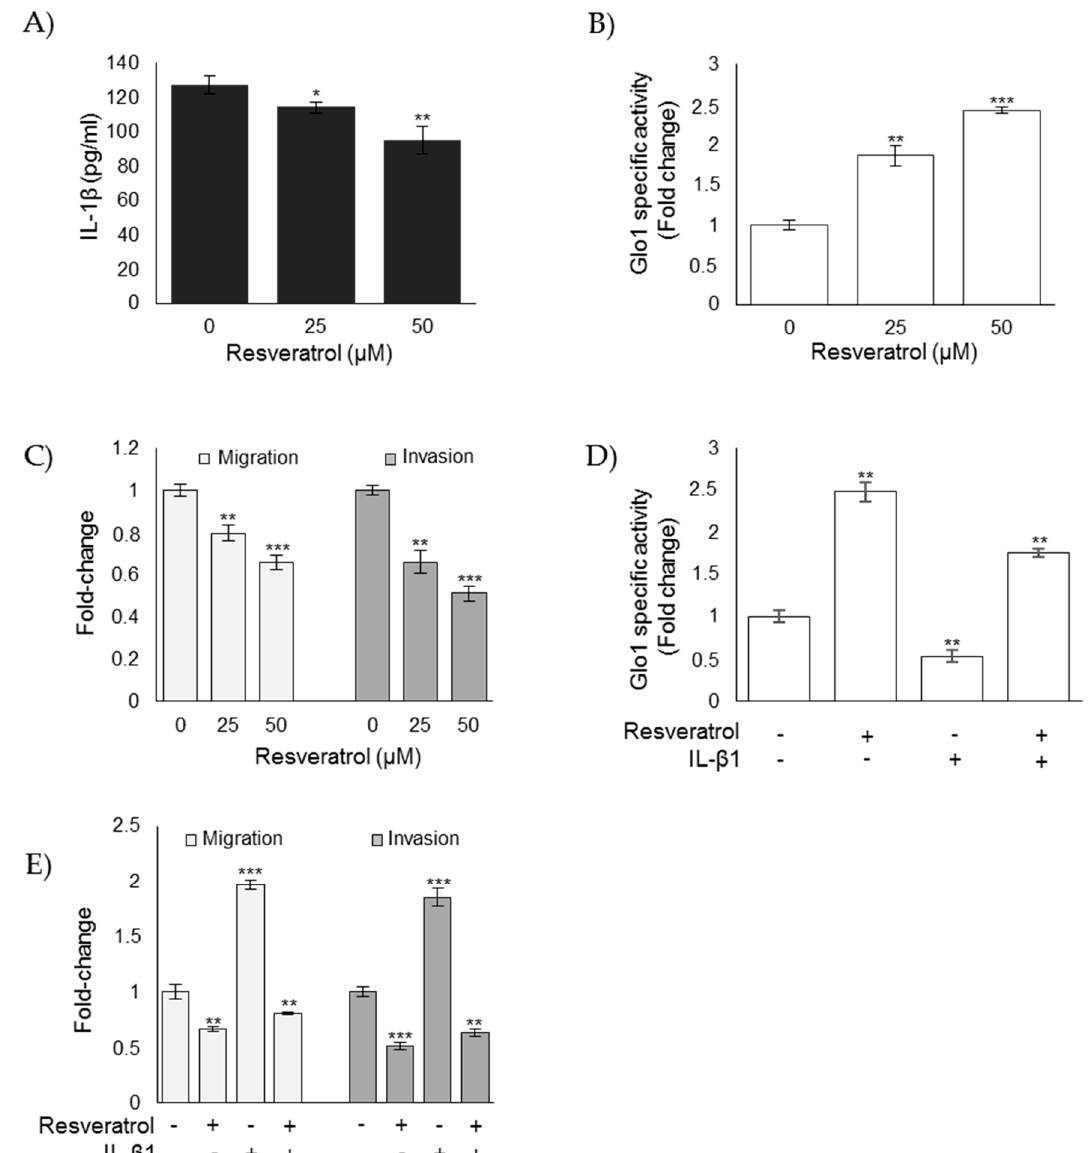
Figure 11. Resveratrol a ff ects the CAL62 cell aggressive phenotype by reducing migration and invasion through the inhibition of IL-1 β -driven, Glo1 / MG-H1-mediated TGF- β 1 / FAK signaling. E ff ect of resveratrol on ( A ) IL-1 β levels, evaluated by an ELISA kit in cell culture medium; ( B ) Glo1-specific activity, measured by spectrophotometry; and ( C ) migration and invasion capabilities, evaluated by specific assays. E ff ect of IL-1 β , under resveratrol administration, on ( D ) Glo1 enzyme activity and ( E ) migration and invasion capabilities. Histograms indicate mean ± SD of three di ff erent cultures, and each was tested in triplicate. * p < 0.05, ** p < 0.01, and *** p < 0.001.